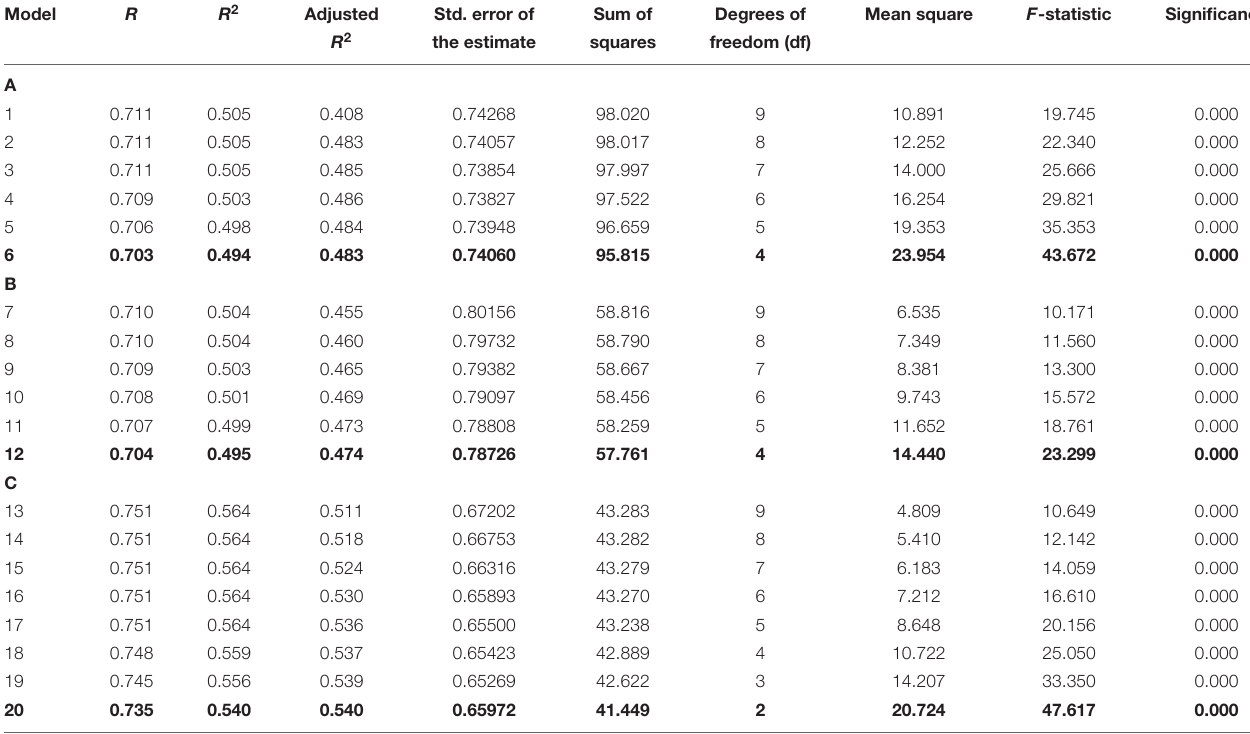
TABLE 3 | Model summary for the backward stepwise linear regression on the physical fitness change scores from Grade 6 to Grade 9, exclusively.